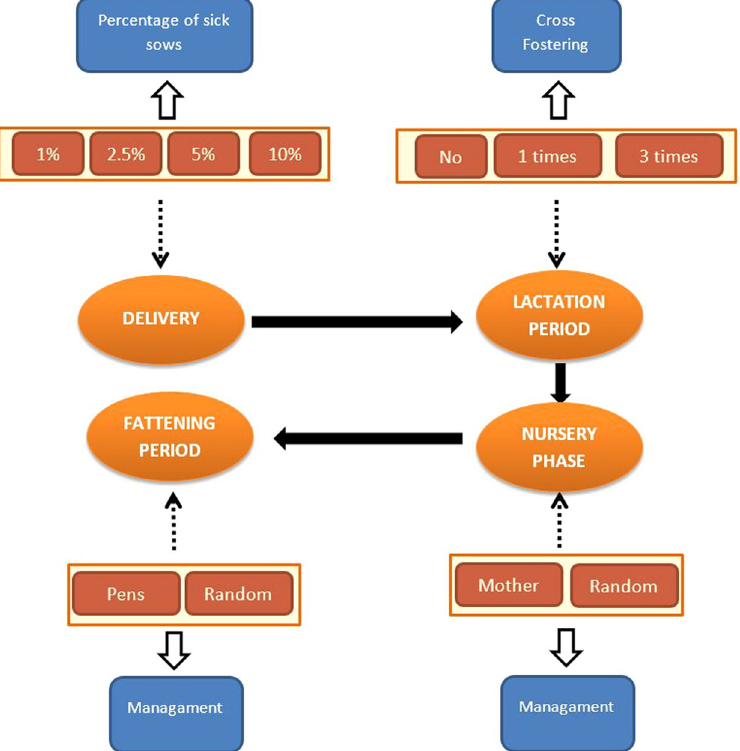
Figure 2. General functioning diagram of a pig farm specifying each production